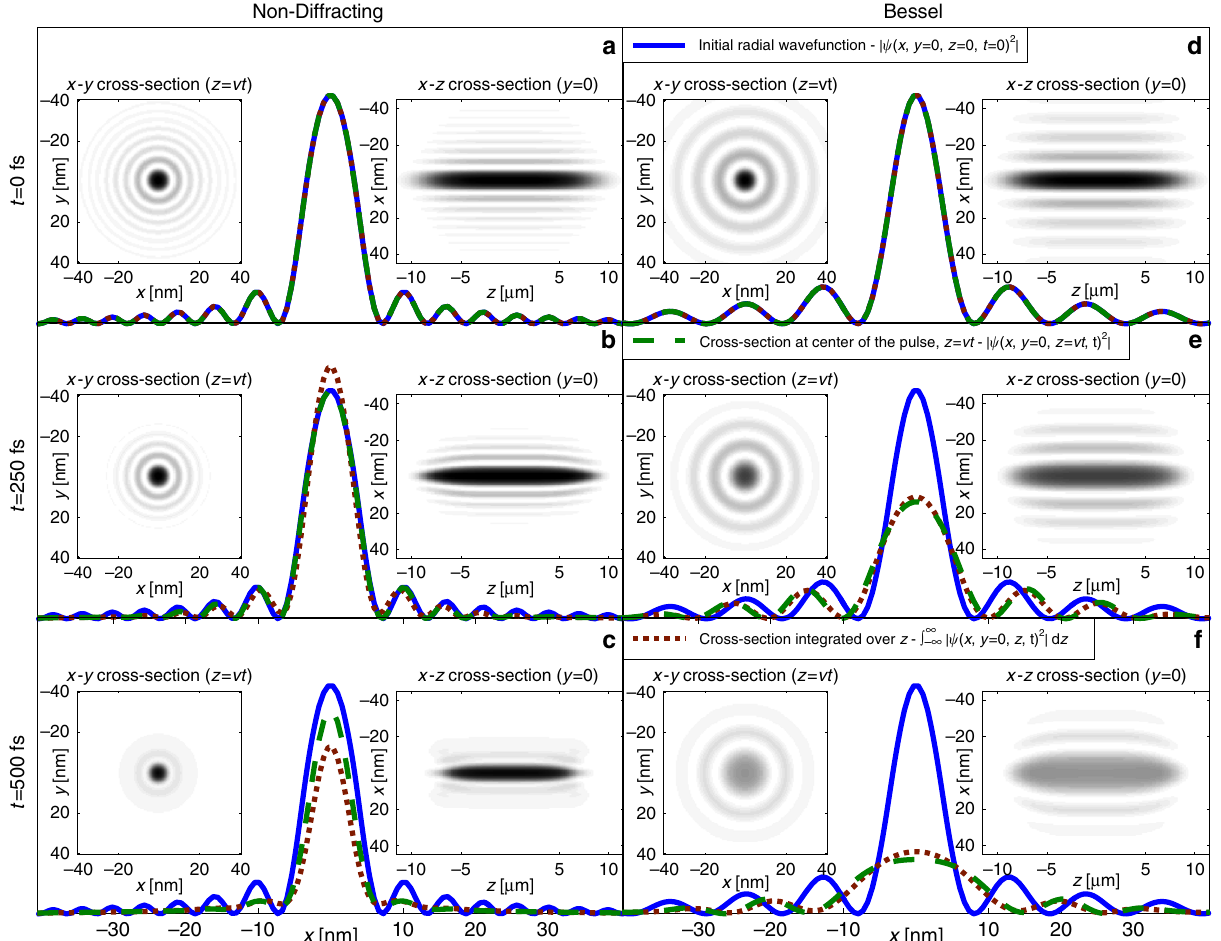
Fig. 6 Temporal evolution of multi-electron pulsed beams. Shown are three frames taken from full 3D + time simulations. a – c present the 3D evolution of our non-diffracting wavefunction, while d – f show the 3D evolution of a Bessel beam. The solid blue lines show radial cross-sections of the beam at the launch plane z = 0 at t = 0, while the green dashed lines show beam cross-sections at the center of the pulse as the beam is evolving with z = vt . The red dotted lines show beam cross-sections integrated over the longitudinal ( z ) extent of the pulse, at different times, which corresponds to the quantity actually measured in experiments. Inserts display transverse shape ( x - y cross-sections) of the wavefunctions ( | ψ ( x , y , z = = vt ) | 2 ) and longitudinal shape ( x – z cross-sections) of the pulse ( | ψ ( x , y = 0, z − vt ) | 2 ). Our non-diffracting beam preserved its shape in space and time up to ~500 fs, while the